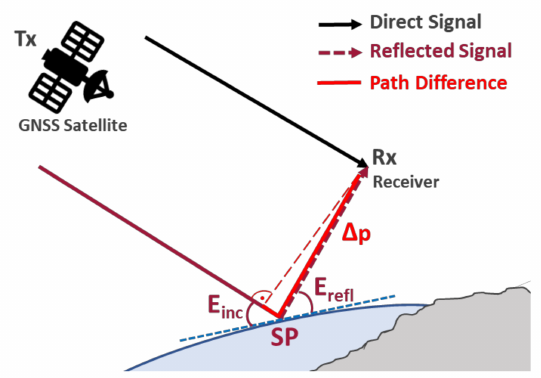
Figure 1. Scheme of GNSS-R configuration. T x is the GNSS satellite transmitter. R x is the receiver installed in a ground-based or moving platform. E inc and E refl are the satellite incident and reflected elevation angles. The reflection point where the incident and reflected angle are the same is called the specular point SP . ∆ p is the excess path that the reflected signal travels with respect to the direct